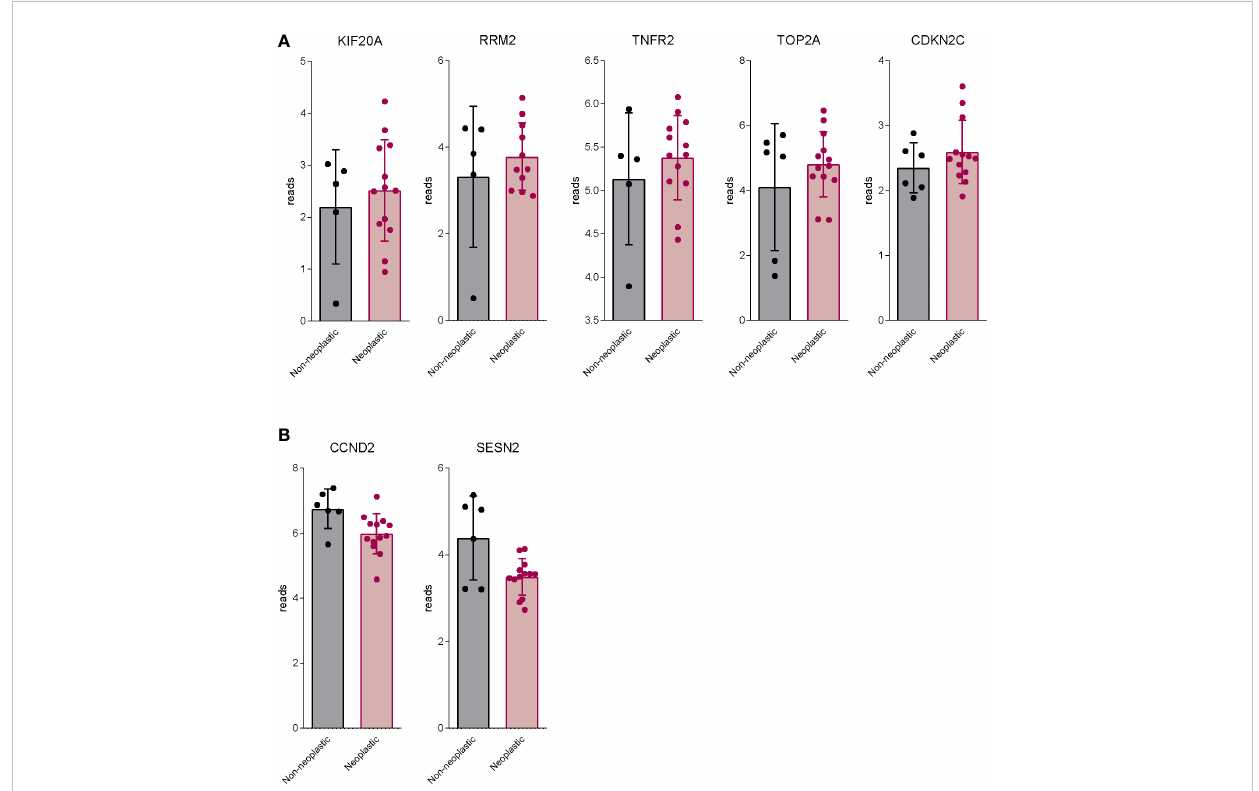
FIGURE 9 BAR502 modulated genes generally regulated aberrantly in PDAC. RNA-seq analysis of non-neoplastic and neoplastic mucosa of PDAC from GSE196009 repository. Each dot represents a patient. Data shown represent the gene pro fi le expression of (A) genes upregulated in human PDAC, which are downregulated by BAR502 exposure in MIA PaCa-2 cells. (B) genes down-regulated in human PDAC, which are upregulated by BAR502 exposure in MIA PaCa-2